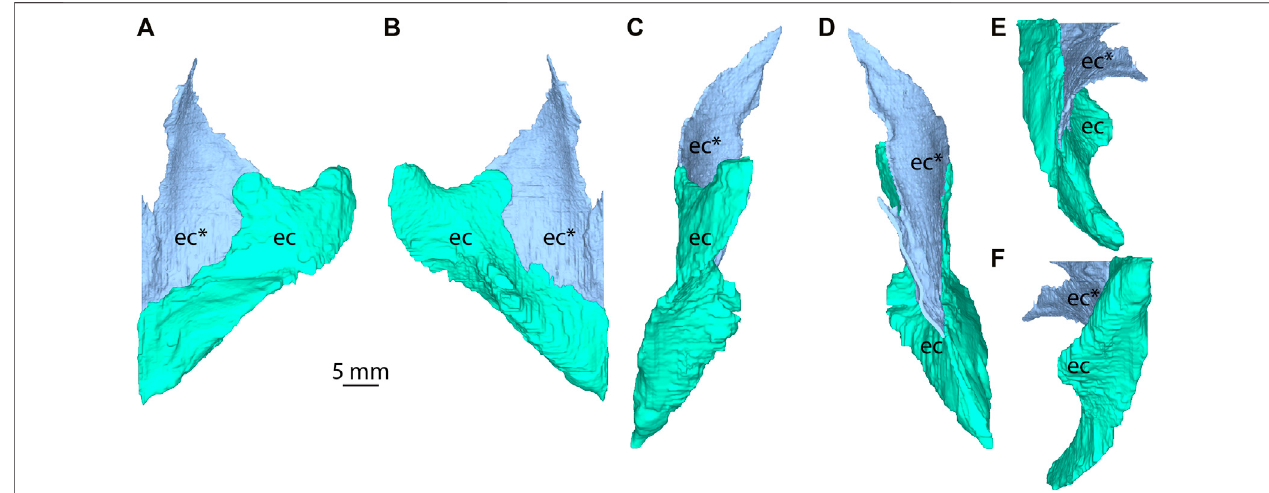
FIGURE5| Three-dimensionalmodelsofSAMAP40536rightectopterygoid. (A) Lateralview. (B) Medialview. (C) Anteriorview. (D) Posteriorview. (E) Dorsalview. (F) Ventral view. Abbreviations: ec, ectopterygoid. 3D models of bones based on impressions are denoted with an asterisk